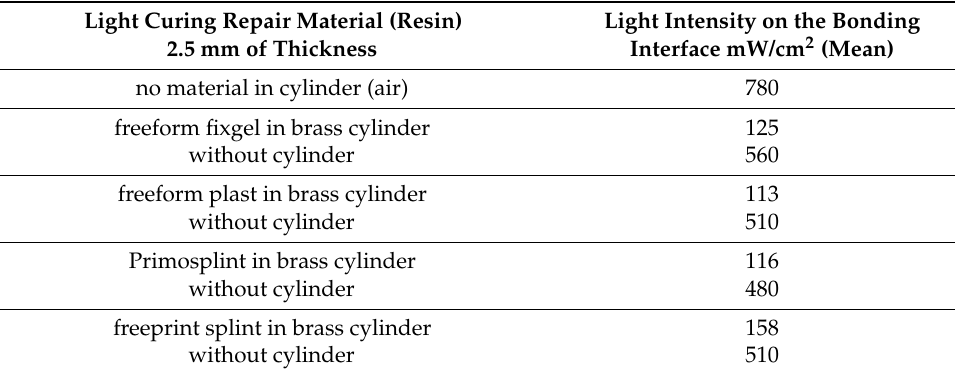
Table 2. Measurement of the light transmission through light-curing